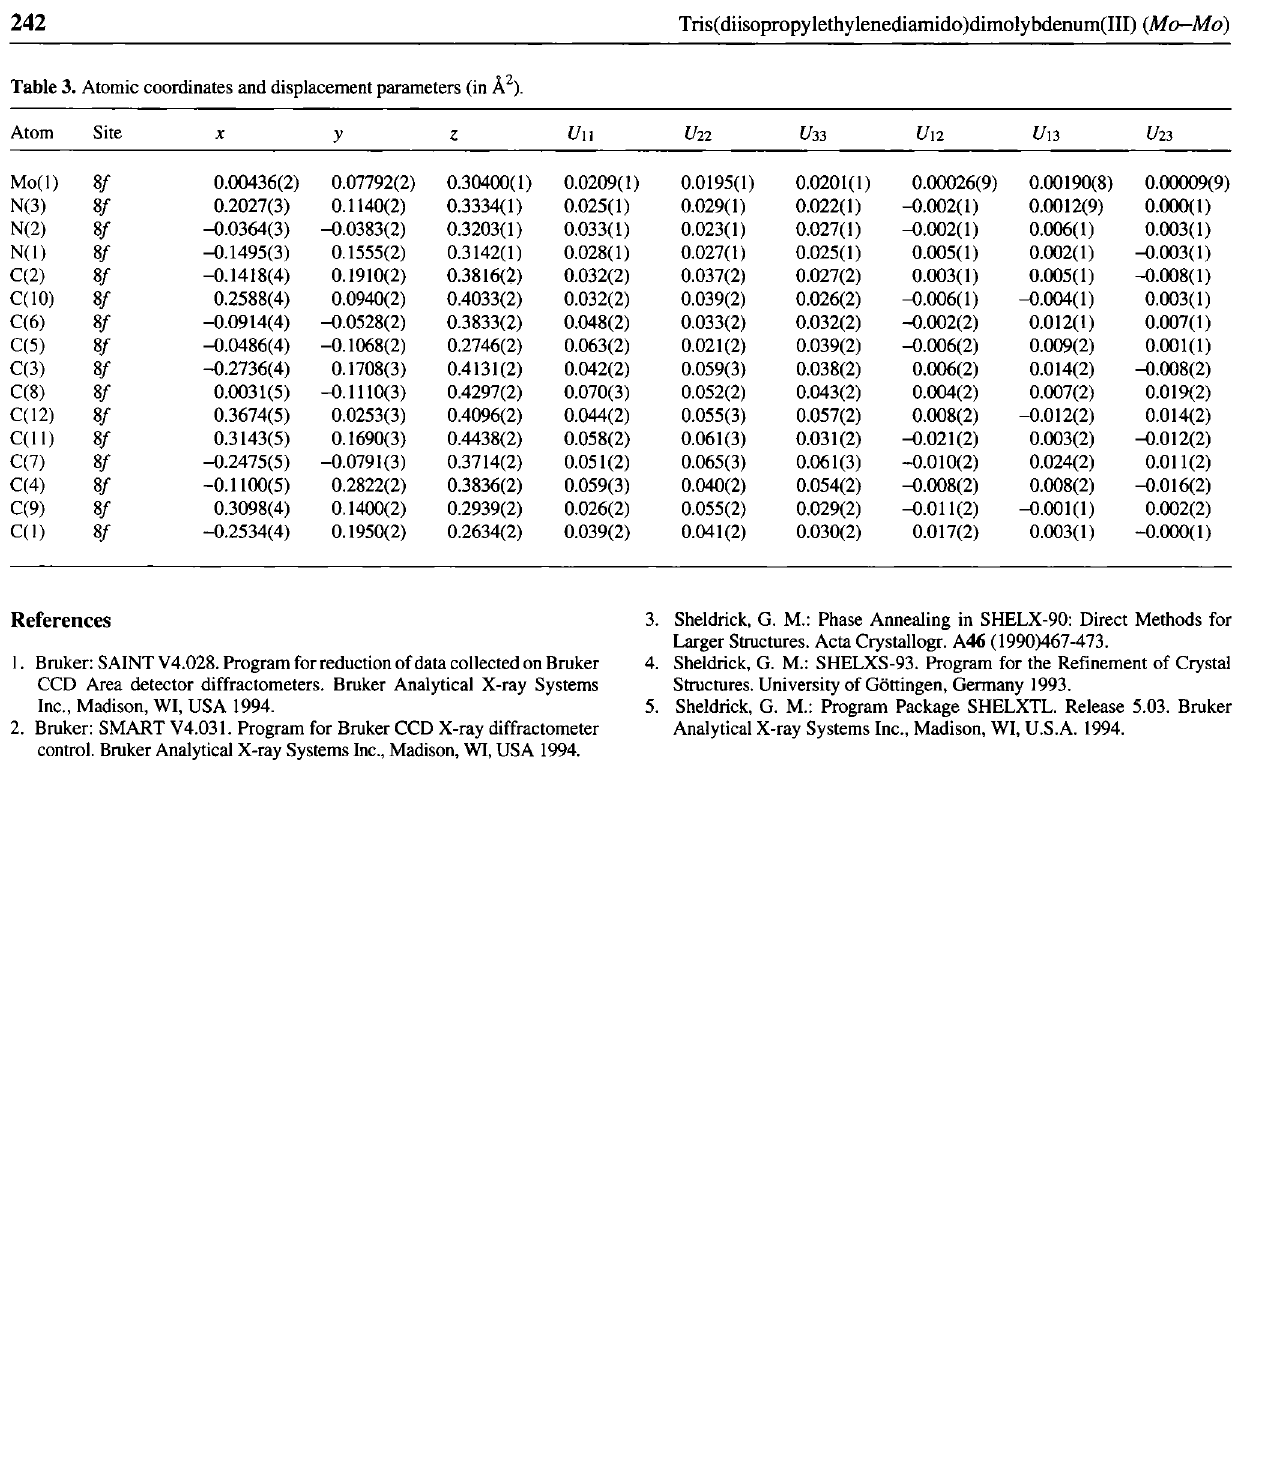
Table 3. Atomic coordinates and displacement parameters (in Ä 2